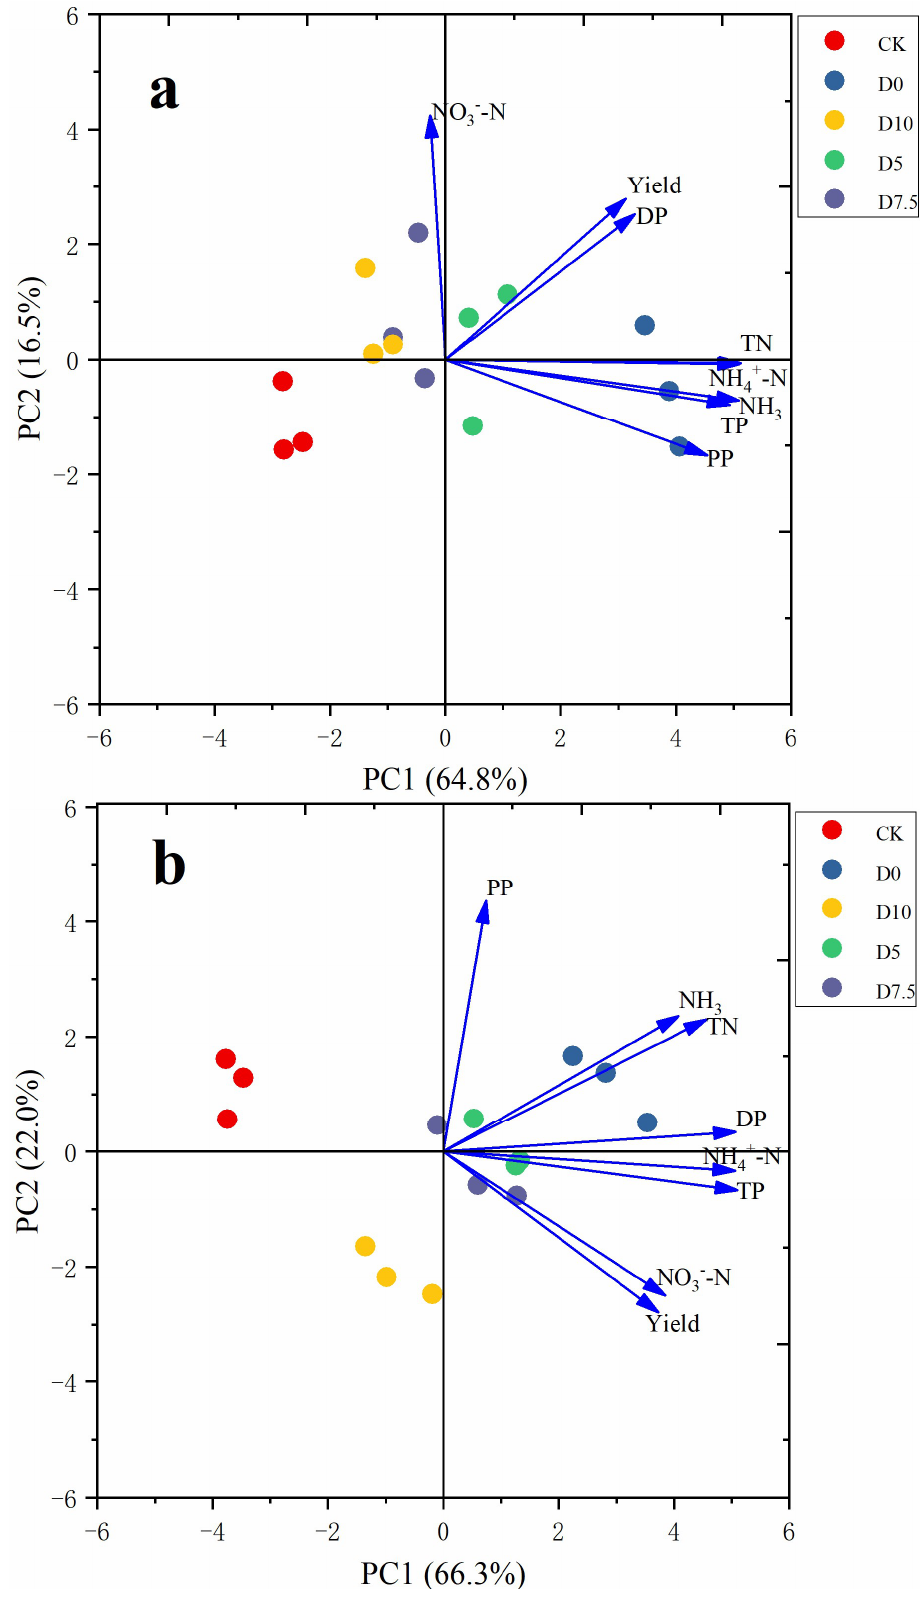
Figure 9. PCA analysis for grain yield and concentration of N and P in surface water in double−cropping rice. ( a ): early rice; ( b ): later rice. Samples are shown by colorful solid circle (treatment: CK, D0, D5, D7.5, and D10 were red, blue, green, brown, and orange, respectively).